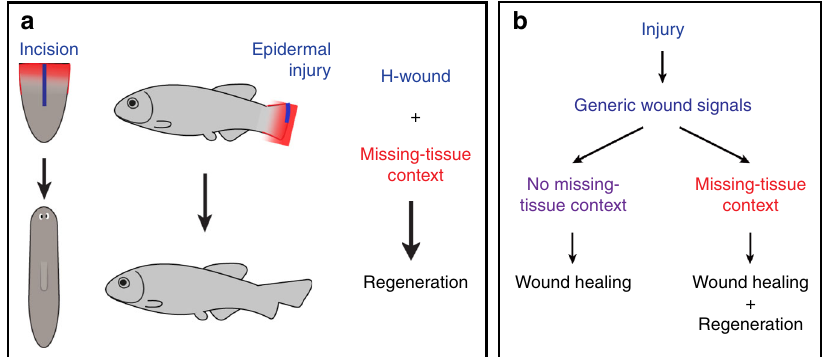
Fig. 7 Generic wound signals initiate regeneration in missing-tissue contexts. a Injuries that normally do not trigger regeneration (H-wounds) do initiate regeneration in planarian dormant tails and zebra fi sh dormant fi ns (missing-tissue contexts). b Signals that are generically induced after all injuries have the capacity to initiate regeneration, but only when induced in